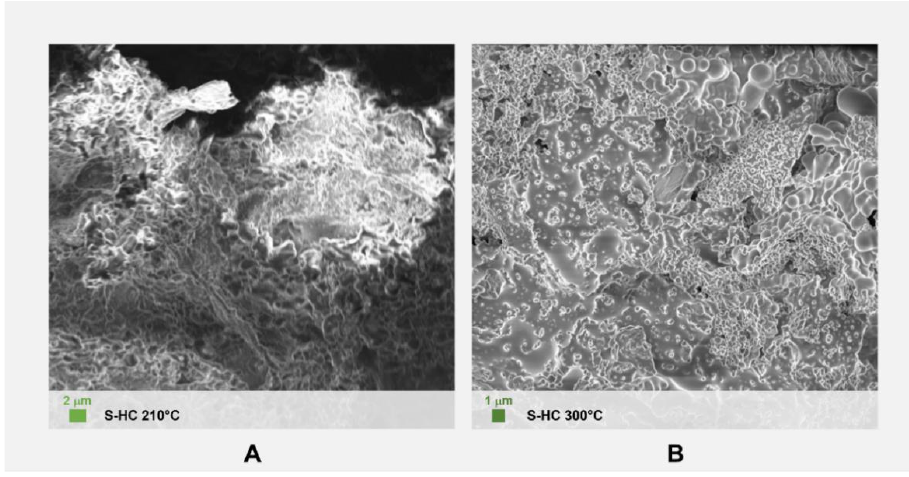
Figure 2. SEM analysis of ( A ) S-HC 210 – 60 and ( B ) S-HC 300 – 60 .